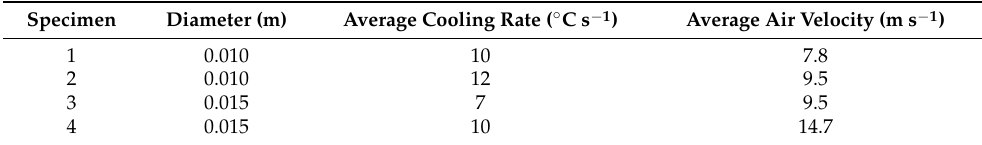
Table 2. Cooling conditions applied to eutectoid steel